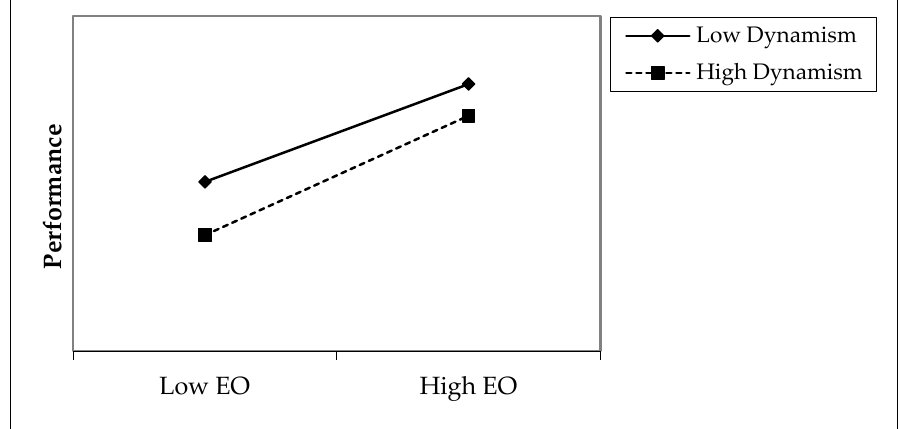
Figure 2. Interaction effect of entrepreneurial orientation and environmental dynamism.